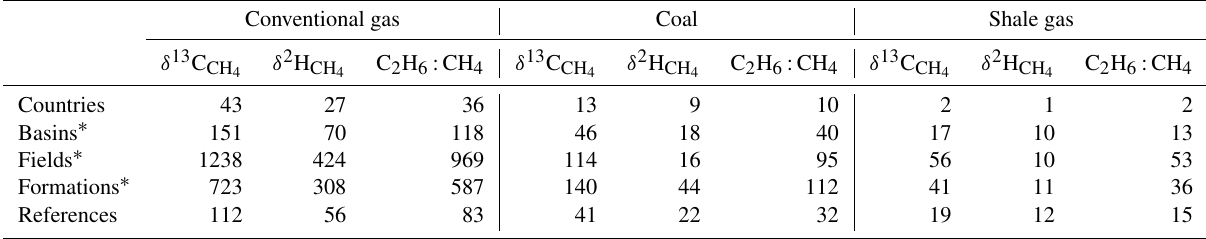
Table 3. Fossil fuel data: number of countries, basins, fields, formations, and references by gas type and specified chemical parameter. Conventional gas Coal Shale gas